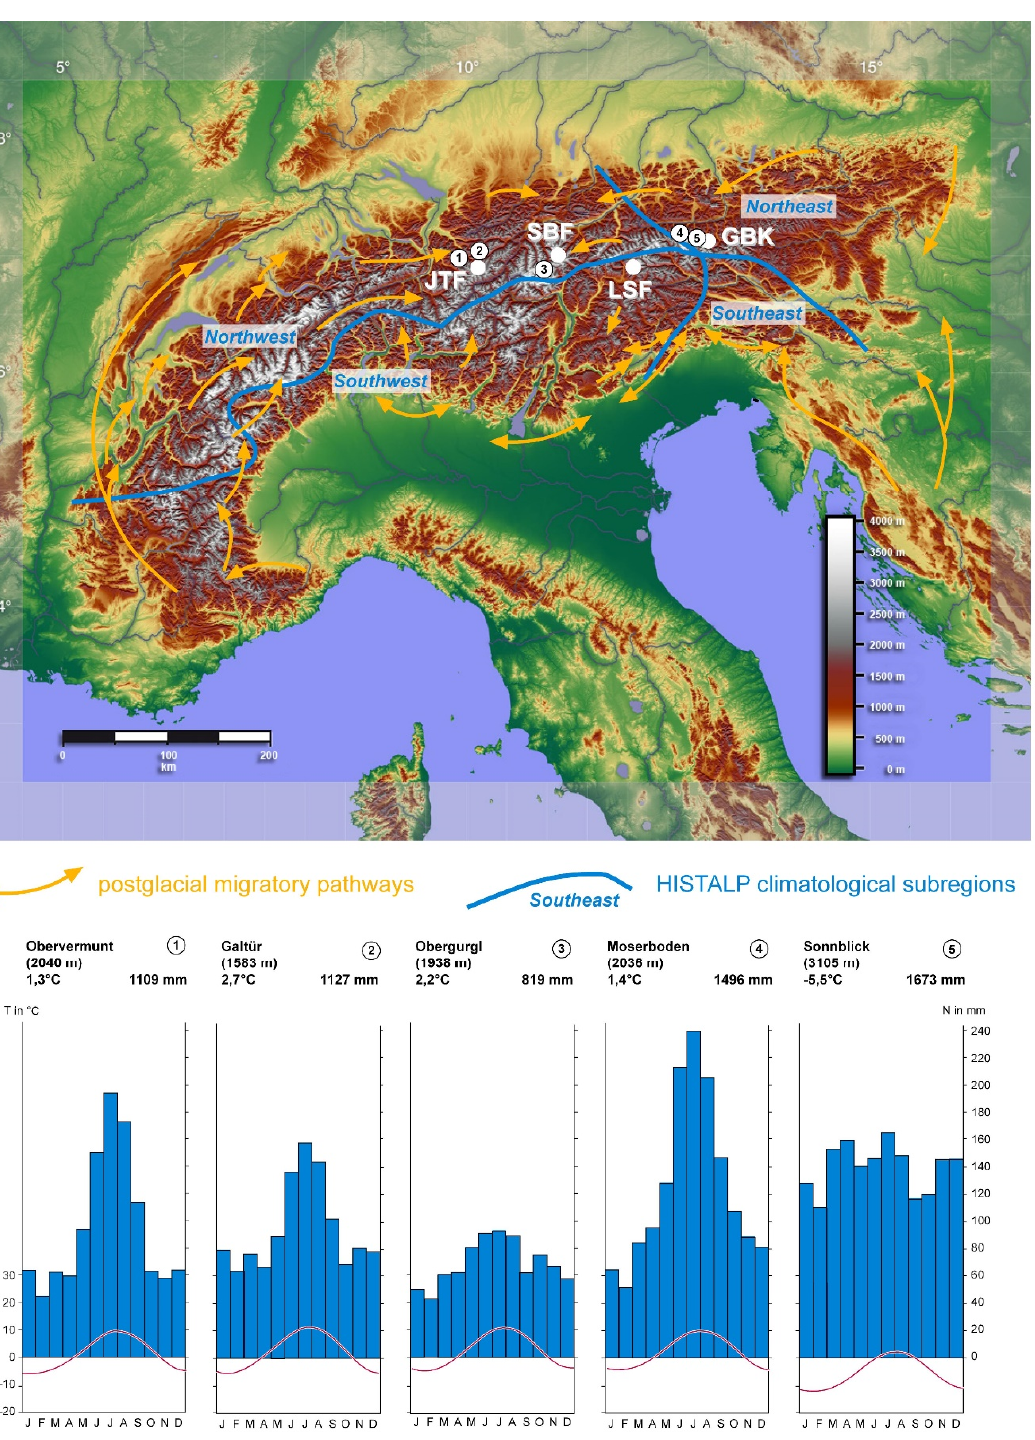
Figure 1. Location of the study areas JTF (Silvretta, Austria), SBF (Stubai, Austria), LSF (Rieserferner, Italy), and GBK (Hohe Tauern, Austria). The blue lines delimit coarse resolution subregions with similar climatic features as defined by the HISTALP (Historical Instrumental Climatological Surface Time Series Of The Greater Alpine Region) dataset [30]. The yellow arrows indicate migratory pathways of plants from glacial refugia and floristic exchange between different parts of the Alps after the end of the last Pleistocene glaciation (according to [33]). Climate charts (1971–2000) based on data of ZAMG (Zentralanstalt für Meteorologie und Geodynamik) [39]; background DEM (Digital Elevation Model) from Wikipedia [40].